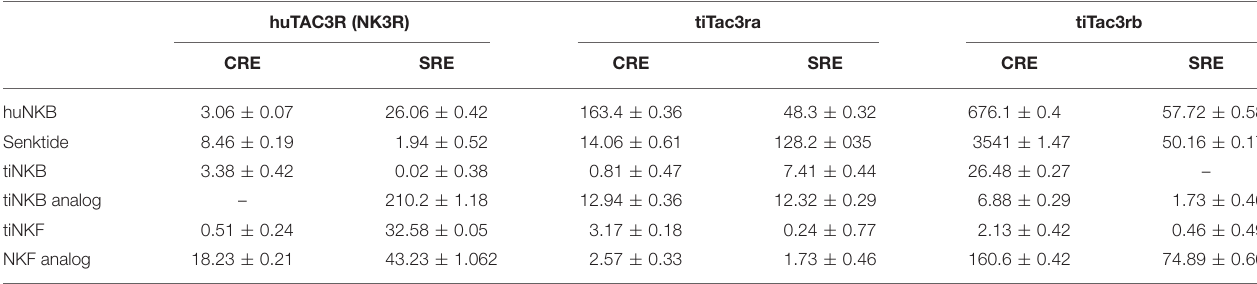
TABLE 2 | EC 50 values (nM) of human and tilapia NKB receptors. huTAC3R (NK3R) tiTac3ra tiTac3rb